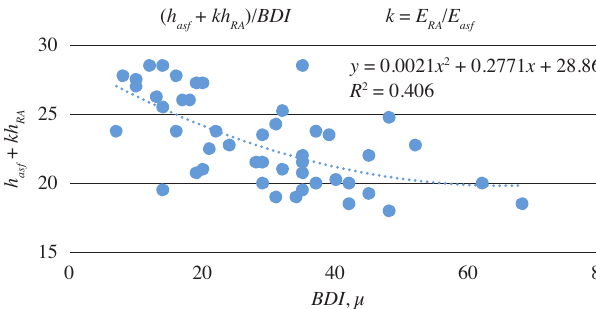
Figure 5. Relationship between function h